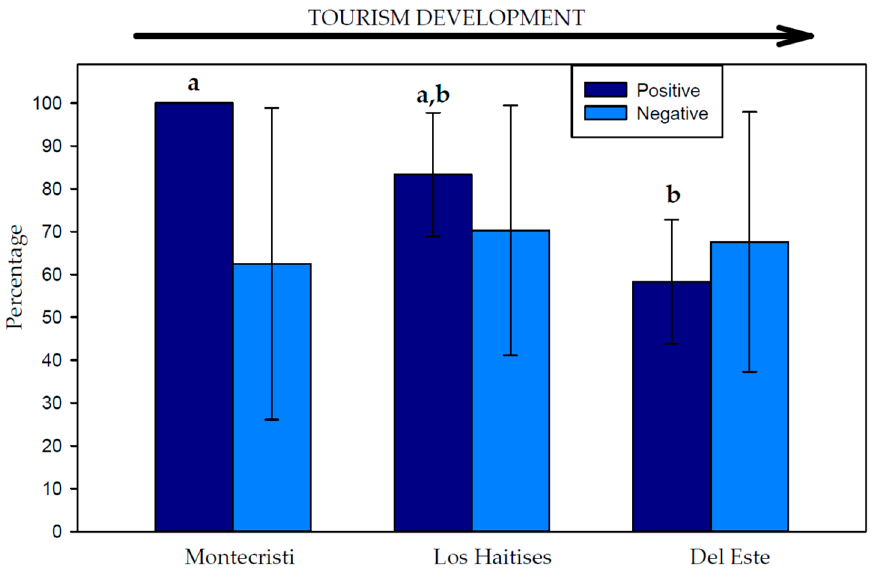
Figure 2. Percentage of participants that perceived positive and negative impacts in each national park. Error bars show standard deviation. Values of positive impacts with the same letter are not significantly different ( p > 0.05) according to a post hoc Tukey HDS (Honestly Significant Difference) test and analysis of variance (ANOVA). Values of negative impacts are not significantly different ( p > 0.05).